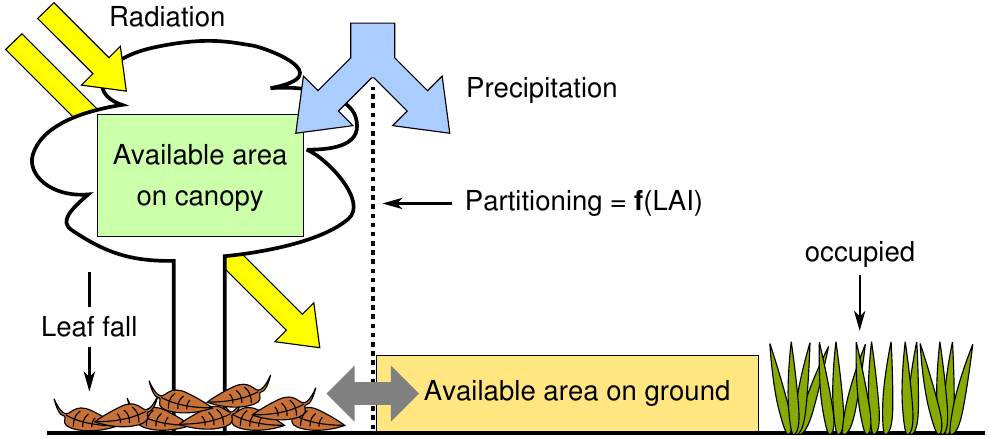
Figure 2: Effect of the Leaf Area Index (LAI) on area for growth and climate forcing. Available area on ground is a linearly decreasing function of LAI. The same function is used to partition precipitation between canopy and soil. The vertical distribution of light is calculated according to Beer’s law as a function of LAI.